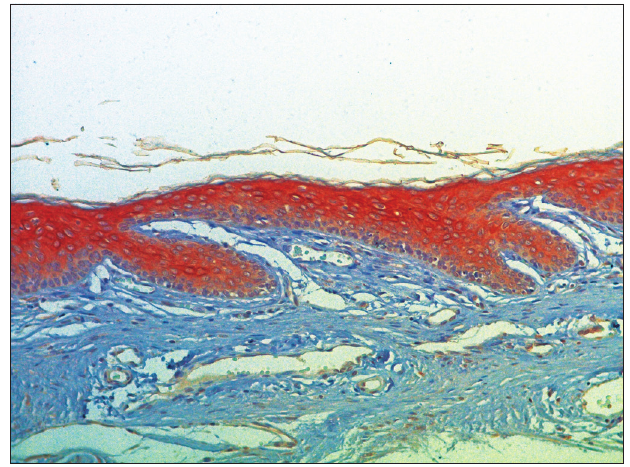
Figura 6. Fotomicrografia mostrando a epiderme da parede inferior do meato acústico externo com expressão de CK16